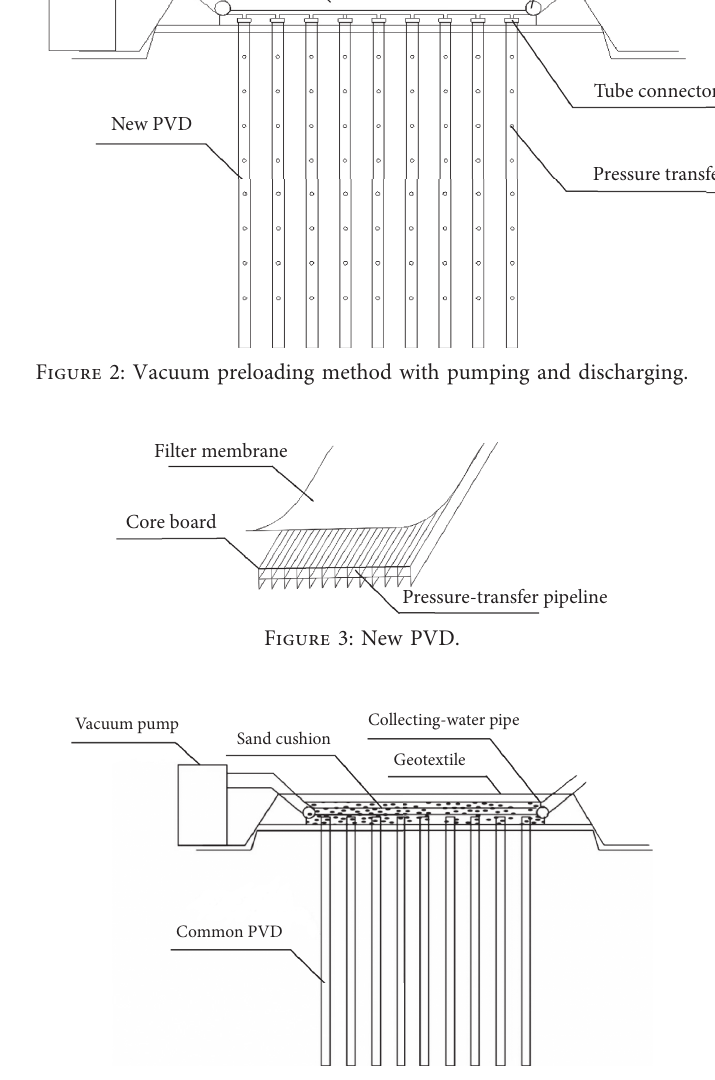
Figure 4: Vacuum preloading method.